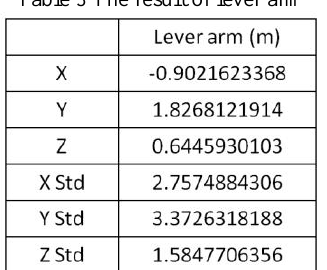
Table 3 The result of lever arm